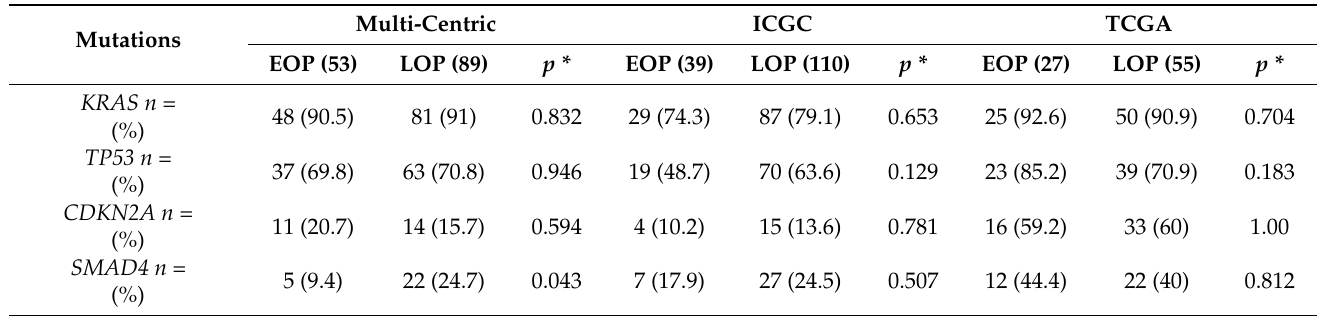
Figure 1. Genomic landscape of pancreatic cancer patients. ( a ) Oncogrid of the top four altered genes ( KRAS , TP53 , SAMD4 , and CDKN2A ) in the Multi-centric cohort, 53 tumors from early-onset patients (EOP), 89 tumors from late onset patients (LOP); ( b ) Oncogrid from the TCGA data portal web application of the TCGA_PAAD project composed of 87 patients, 30 tumors from EOP (orange) and 57 tumors from LOP (green). Genes are ordered by decreasing alteration frequencies in each tumor. Each type of gene mutation is represented as a colored dot, red: Missense mutation, grey: loss of the start codon, purple: gain of the stop codon, green: coding sequence frameshift, yellow: loss of the stop codon. Table 3. Genomic landscape of the multi-centric ICGC and TCGA from EOP and